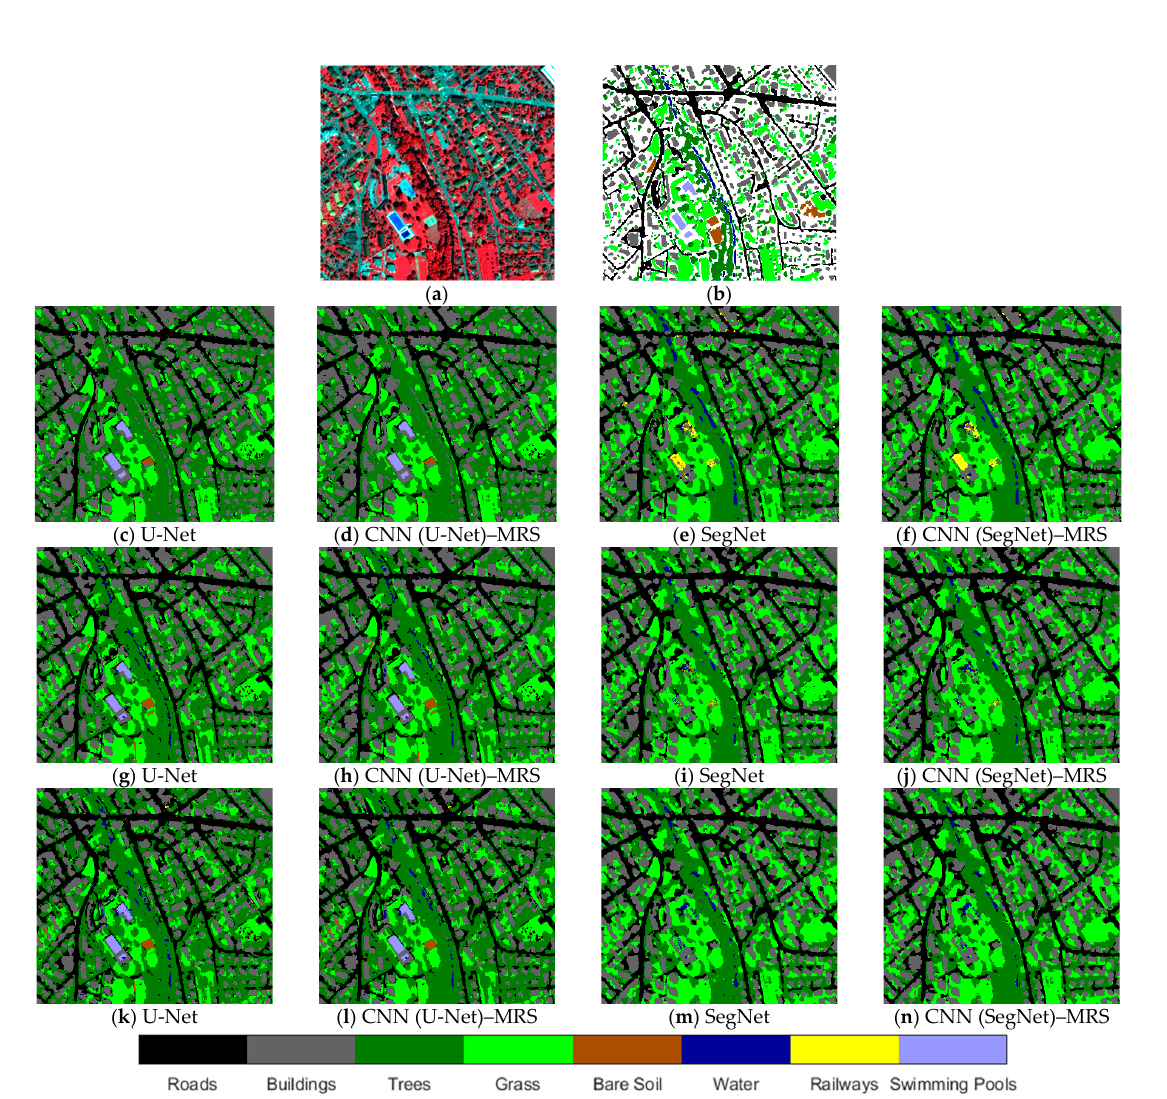
Figure 19. Results of Zurich dataset (ZH-17): ( a ) original image; ( b ) ground truth; ( c – f ) 32 × 32 patch size; ( g – j ) 64 × 64 patch size; ( k – n ) 128 × 128 patch size.